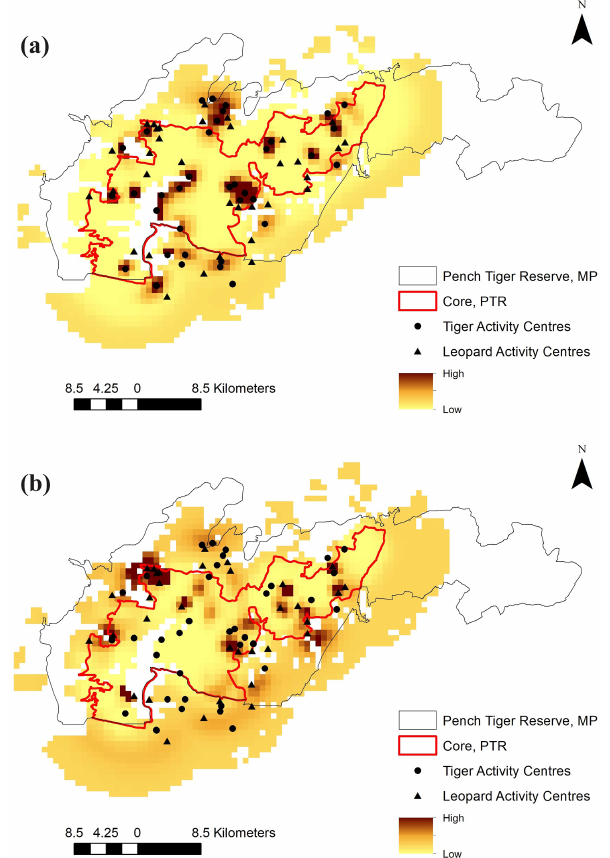
Figure 2. Spatial distribution pattern mapped in terms of realised capture process of (a) tigers and (b) leopards in the intensive study